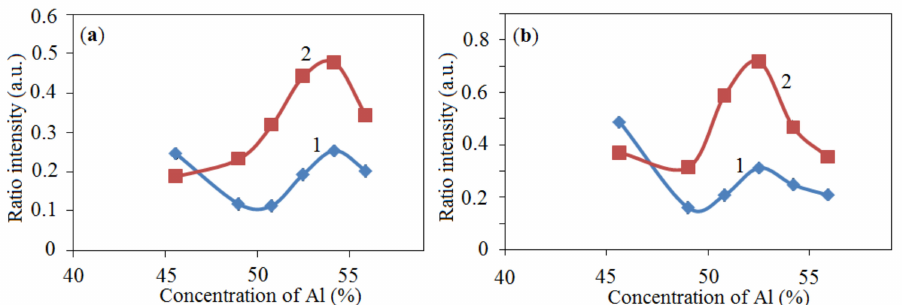
Figure 5. The influence of the Al content in NiO–Al–Al 2 O 3 catalysts on the phase ratio: ( a ) 1—NiAl/Al, 2—NiAl/NiO; ( b ) 1—NiAl 2 O 4 /Al, 2—NiAl 2 O 4 /NiO.